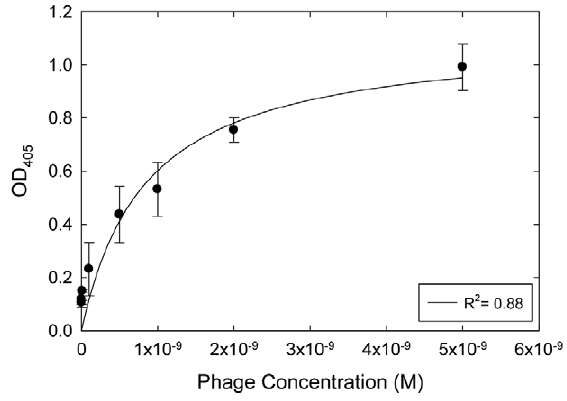
Figure 3. Determination of the apparent dissociation constant of ALT5-8 for ALT. ELISA experiments were performed in triplicate at eight different phage concentrations and the data were fit by a Langmuir isotherm (R 2 =0.88) in order to estimate the apparent equilibrium dissociation constant (K d,app =85 6 20 nM.).